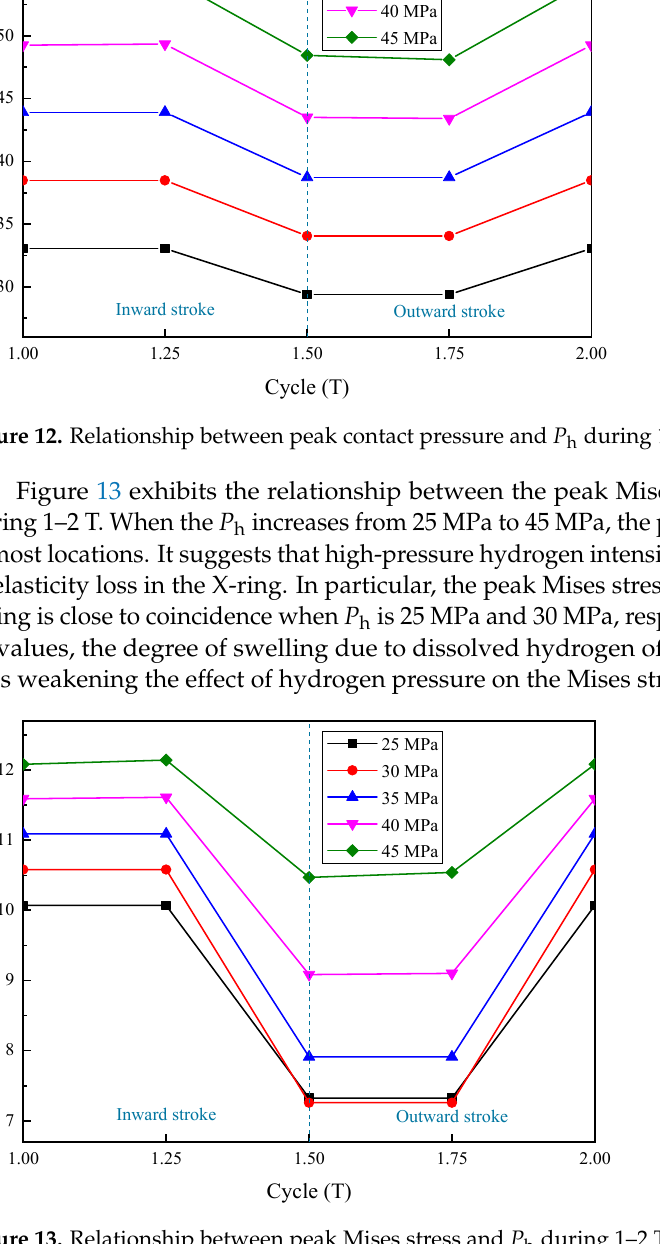
Figure 13. Relationship between peak Mises stress and P h during 1–2 T. Figure 14 manifests the Min peak contact pressure and Max peak Mises stress of X-ring and O-ring at various P h during 1–2 T. When the P h increases from 15 MPa to 35 MPa,